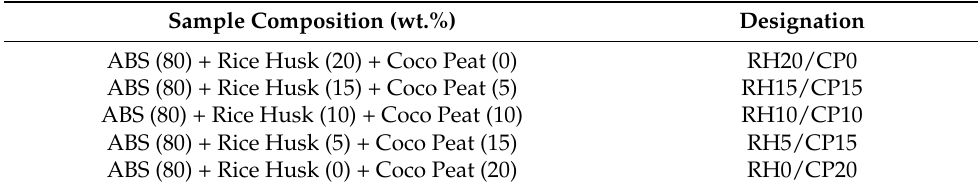
Table 1. Sample composition and